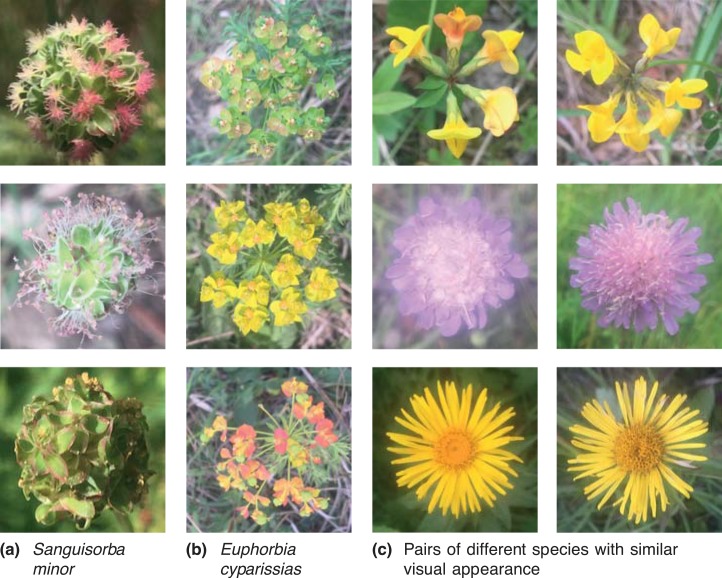
Challenging examples from the Jena Flower 30 (JF30) dataset.(a) and (b) Evolution of two flowers throughout the season and (c) Species with similar visual appearance: Lotus corniculatus vs. Hippocrepsis comosa, Scabiosa columbaria vs. Knautia arvensis, Inula hirta vs. Inula salicina.